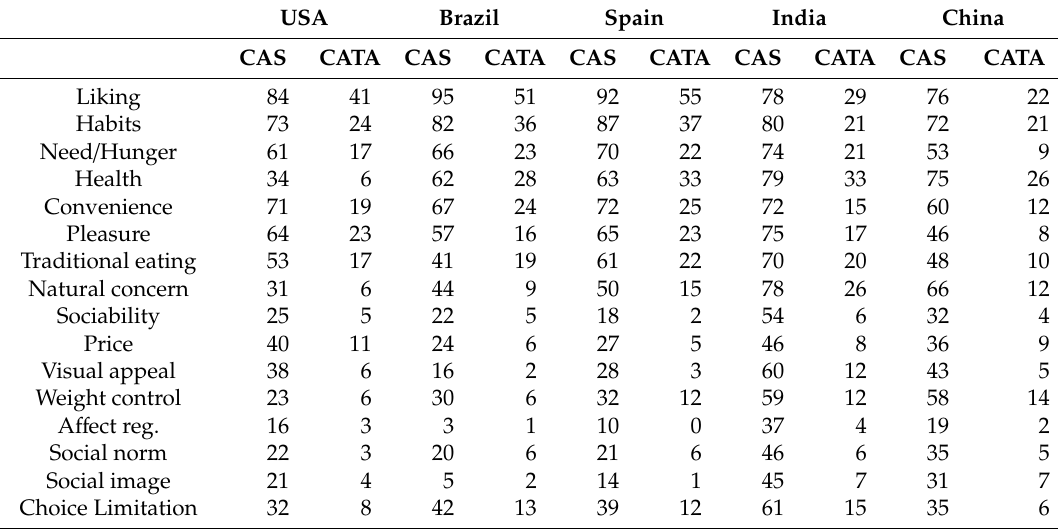
Table A2. Percentage of “agree” responses for CAS and CATA for all five countries for the respective milk and dairy foods. *